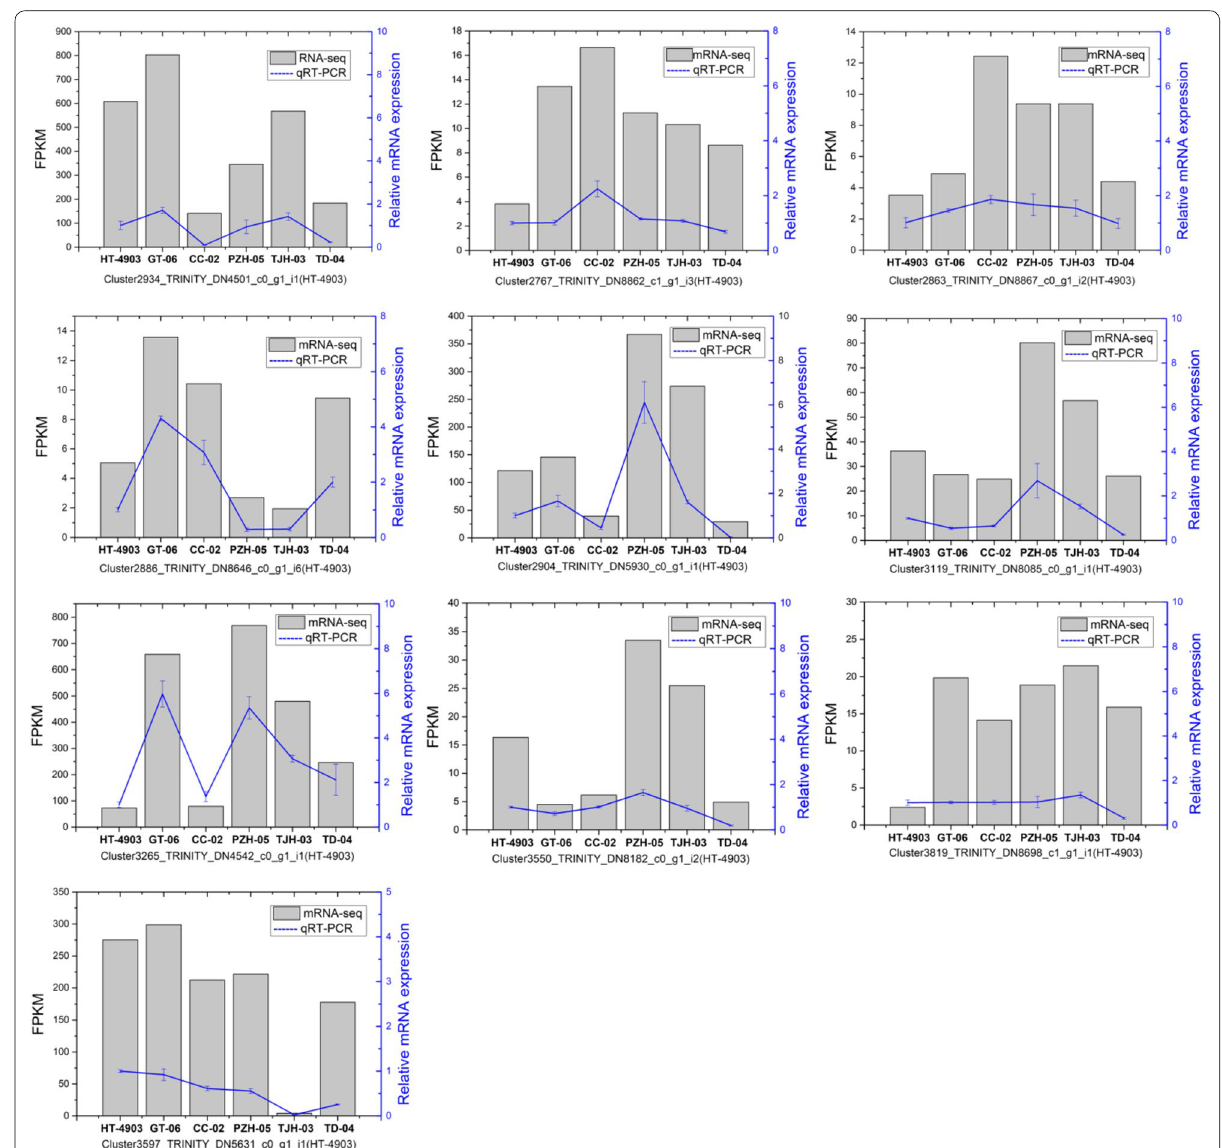
Fig. 7 qRT-PCR confirmation of 10 expressed genes in the six H. erinaceus strains. The expression patterns of selected genes were analyzed across six samples. Gray bars with standard errors represent the FPKM values according to RNA-Seq (left y-axis), and blue lines indicate the relative expression level determined by qRT-PCR (right